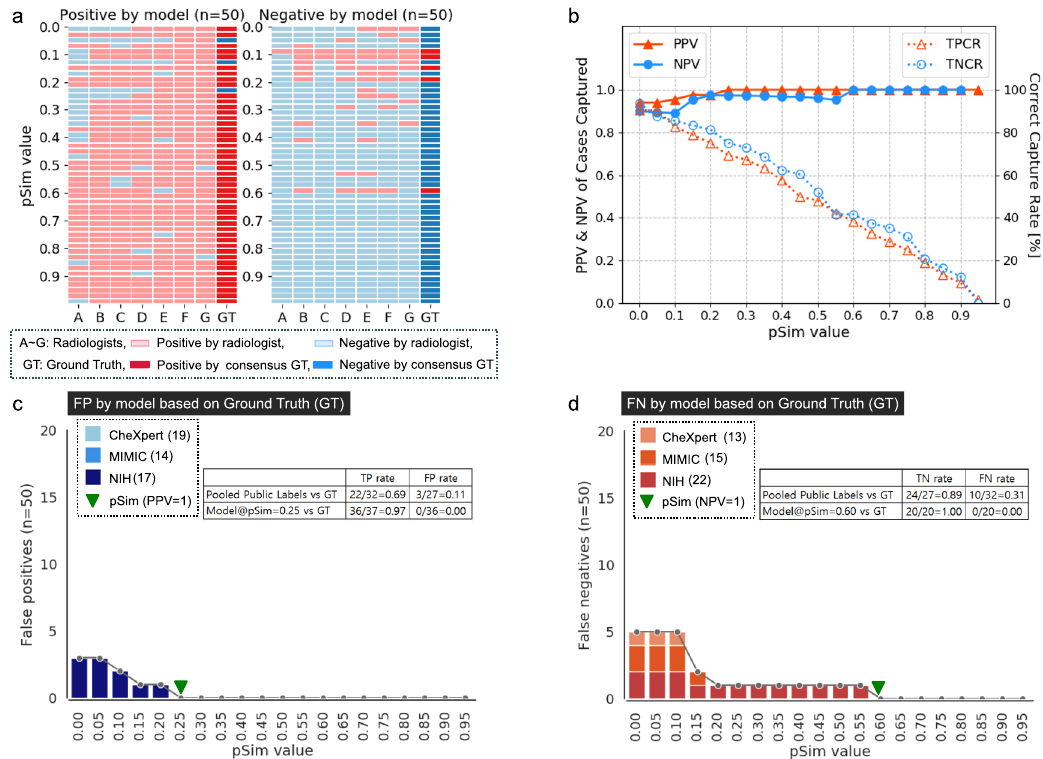
Fig. 4 Automated-labeling model performance applied to three open-source CXR datasets, compared to consensus ground truth of seven expert radiologists, applied to the atelectasis label. Please refer to Fig. 2 for a – d